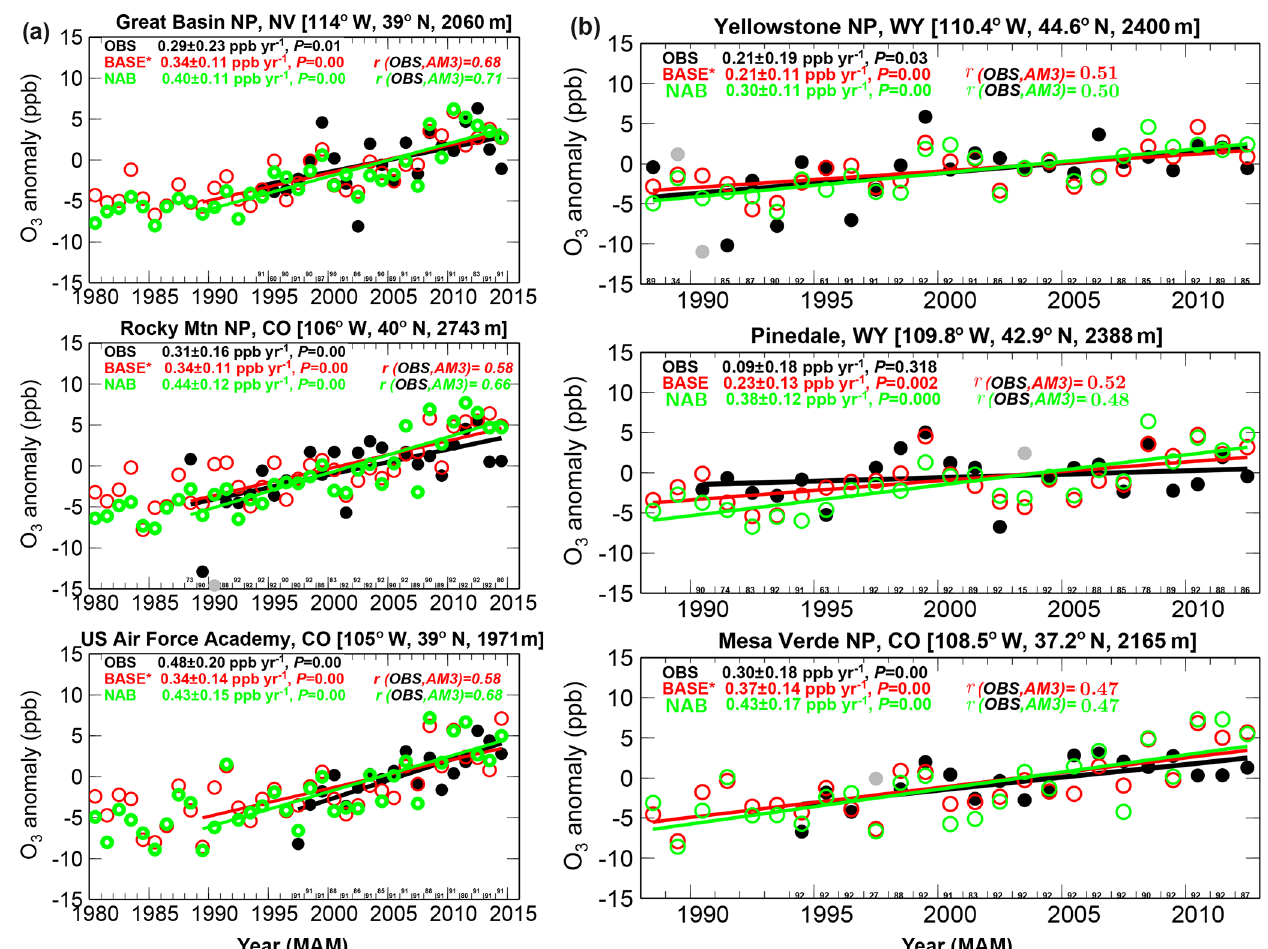
Figure 13. (a) Time series of median spring MDA8 O 3 anomalies (relative to the 1995–2014 mean) at Great Basin, Rocky Mountain, and US Air Force Academy as observed (black) and simulated in AM3 BASE filtered for baseline conditions (red; see Sect. 2.4) and in Background with North American anthropogenic emissions zeroed out (NAB; green). Presented at the top of the graph are statistics from the linear fit and correlations between observations and simulations. Numbers at the bottom of the graph denote the sample size of observations for each year. Gray dots indicate uncertain observations that are removed from the linear fit (see Sect. 2.3). (b) Same as Fig. 13a, but for